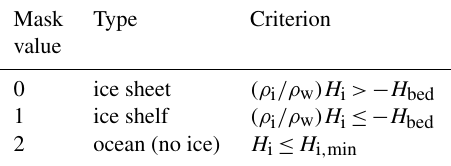
Table 2. Definition of the ice mask. The ice-shelf criterion is that for uniform ice with density ρ i floating on ocean water with density ρ w . The minimum ice thickness used here is H i , min =